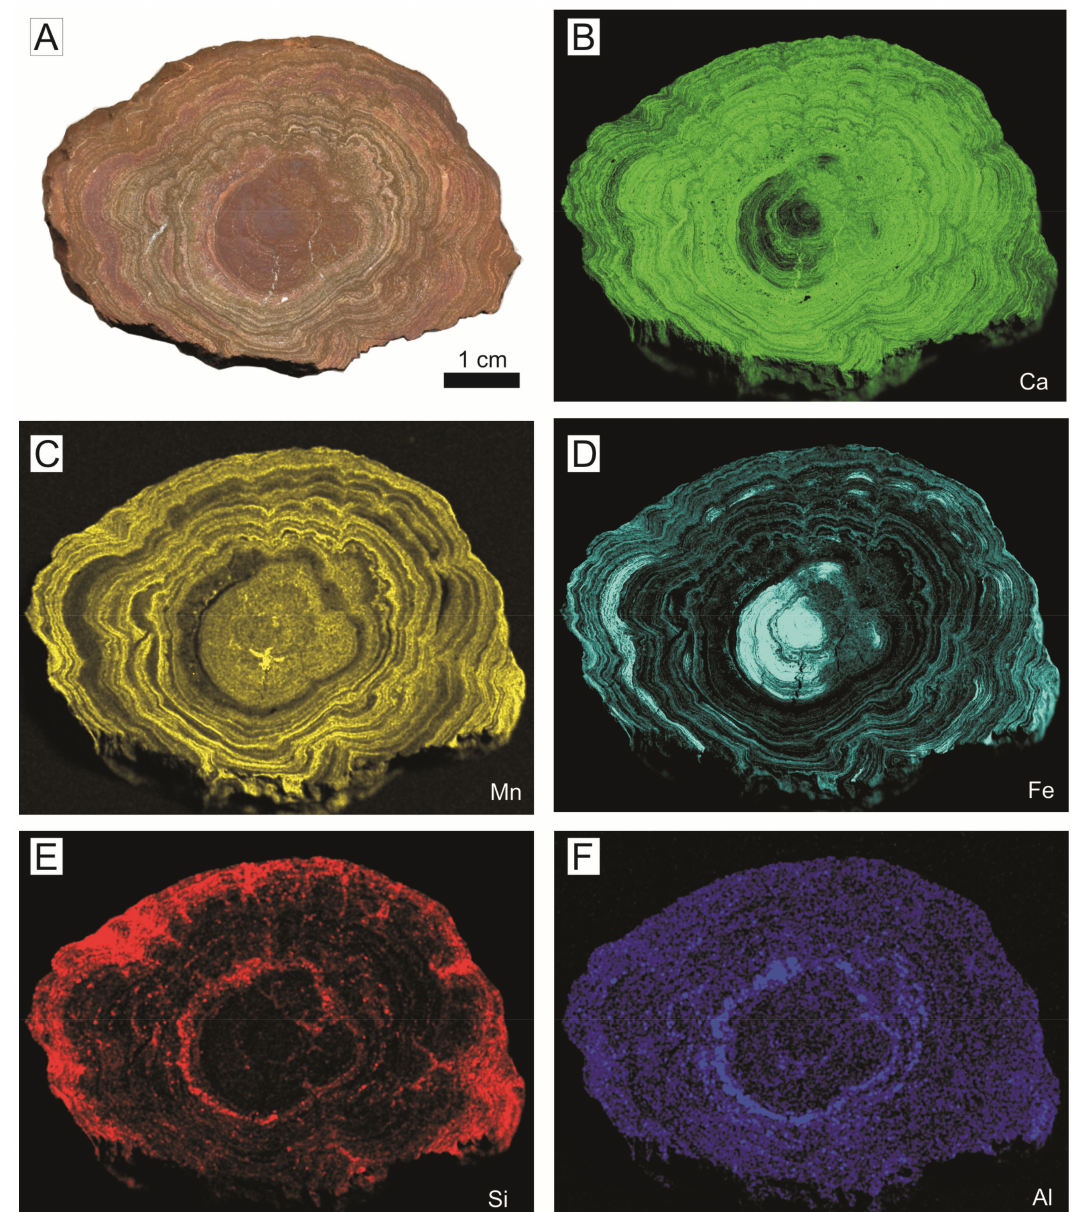
Figure 9. Elemental maps of XR-microfluorescence of an iron macro-oncoid ( A ) from L ú gar outcrop (Eastern External Subbetic, Bathonian hardground) for Ca, Mn, Fe, Si, and Al ( B – F ). Elemental maps for Mn and Fe show cyclicity in the content, whereas Si and Al are concentrated in a concentric clay-rich